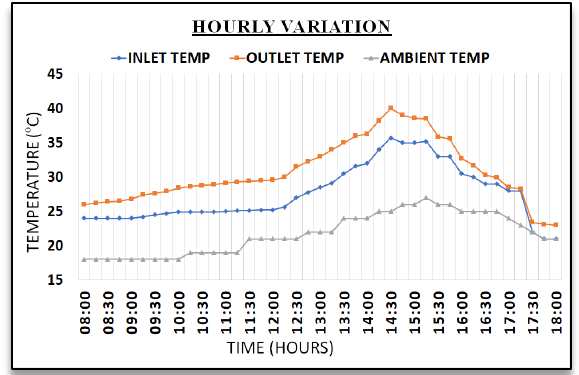
Figure 11. Setup of Flat plate SWH